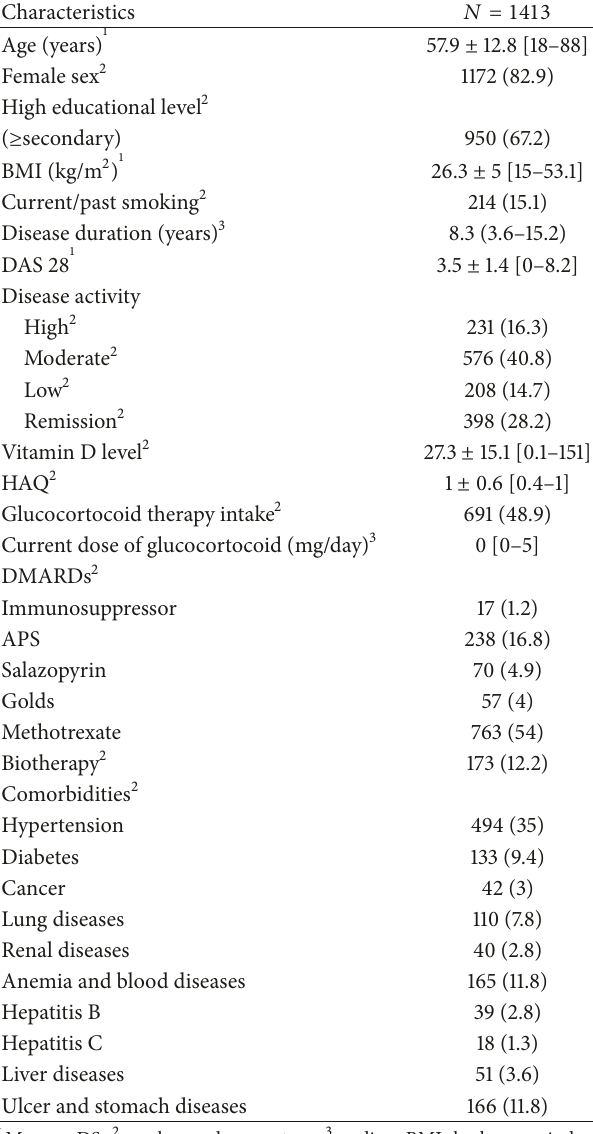
Table 1: Demographic and disease characteristics of rheumatoid arthritis